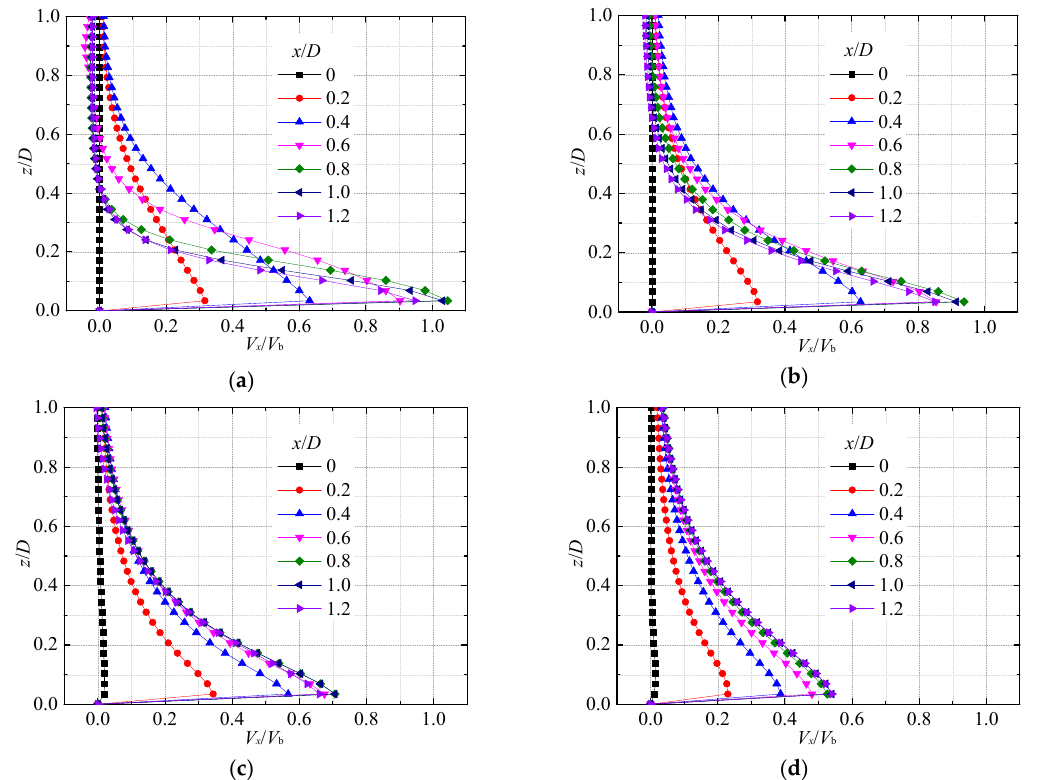
Figure 10. Development of mean horizontal velocity ( V x /V b ) along the horizontal direction at different vertical locations on the near-wall region:( a ) H / D = 1; ( b ) H / D = 3; ( c ) H / D = 6; ( d ) H / D = 8.